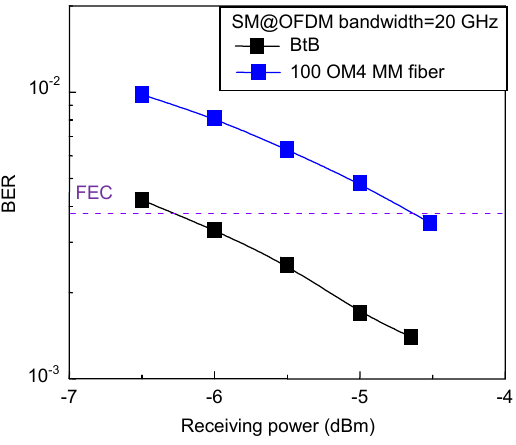
Fig. 10 | BER of the 100-m OM4-MM fiber transmitted 16-QAM- OFDM data for SM VCSEL under the different receiving